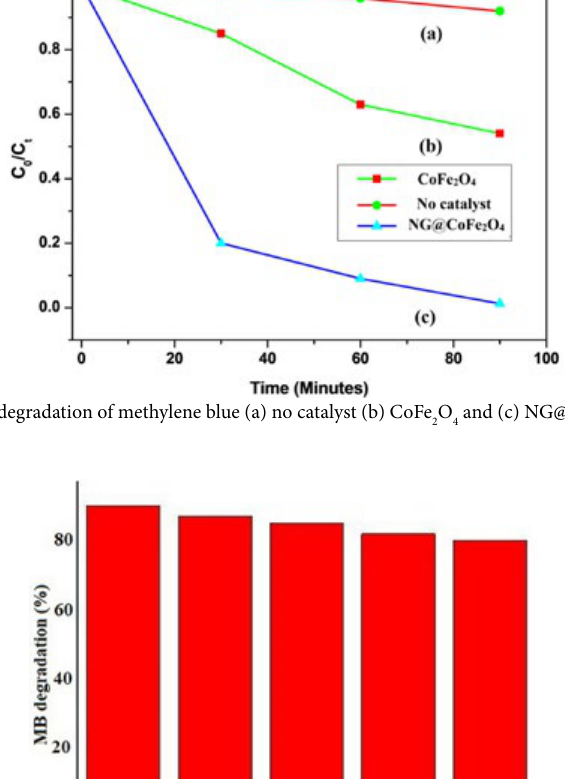
Fig. 11: Removal efficiency of MB on NG@CoFe Fig. 11 Removal efficiency of MB on NG@CoFe 2 O 4 in different catalytic cycles